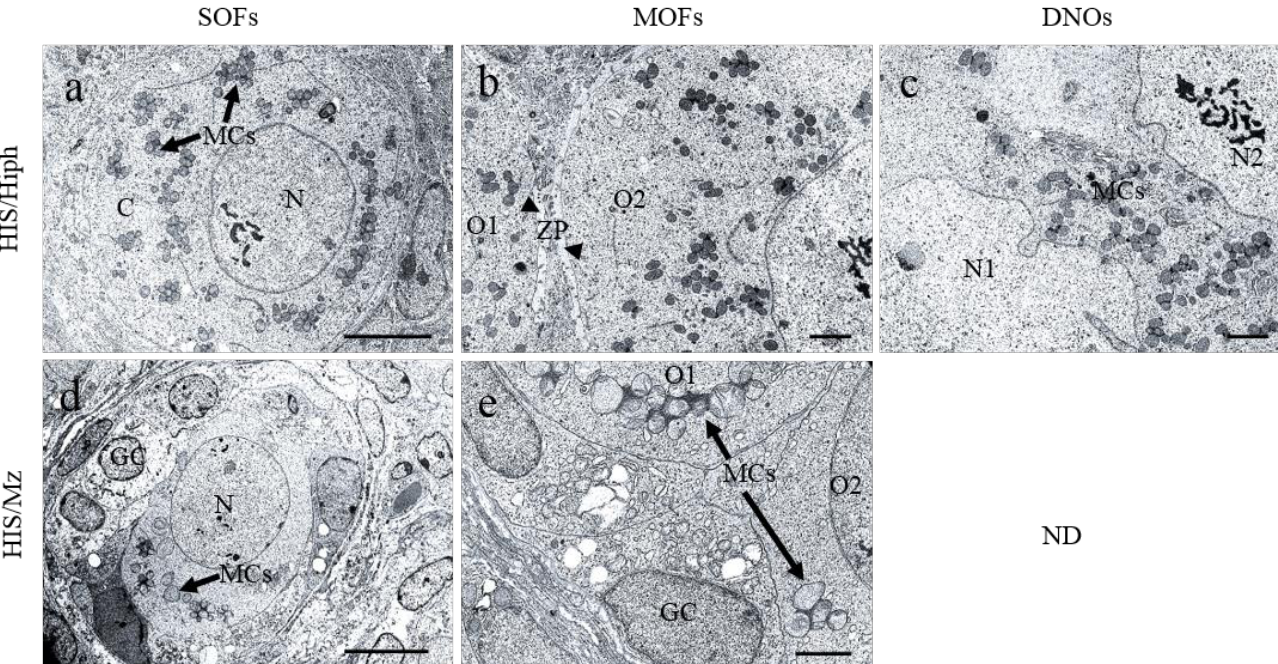
Figure 8. Ultrastructures of ovarian follicles and oocytes in HIS/Hiph and HIS/Mz. Panels are transmission electron microscopy images of the ovary sections of 4-week-old HIS/Hiph and HIS/Mz. Panels ( a – c ) and ( d , e ) show representative images of HIS/Hiph and HIS/Mz ovaries, respectively. Panel ( a ) indicates a single-oocyte follicle (SOF) with a clear round-shaped nucleus (N) and mitochondrial clouds (arrows) distributed throughout the cytoplasm and oriented as a grape-like structure. Panel ( b ) shows a multi-oocyte follicle (MOF) with differentiated oocytes (O1 and O2) separated by the clear zona pellucida (ZP) (arrowhead). Panel c shows double-nucleated oocytes (DNOs) and nuclei (N1 and N2) that are separated by mitochondrial clouds (MCs) (arrows). Panels ( d , e ) show the SOF and MOF in the HIS/Mz ovary; a few MCs (arrows) are observed in SOFs and MOFs, and each MC shows a low electron density as compared to that of HIS/Hiph MCs. Scale bars = 5 µm in panel a; 2 µm in panels b, c, and e; 10 µm in panel d. ND: Not detected.